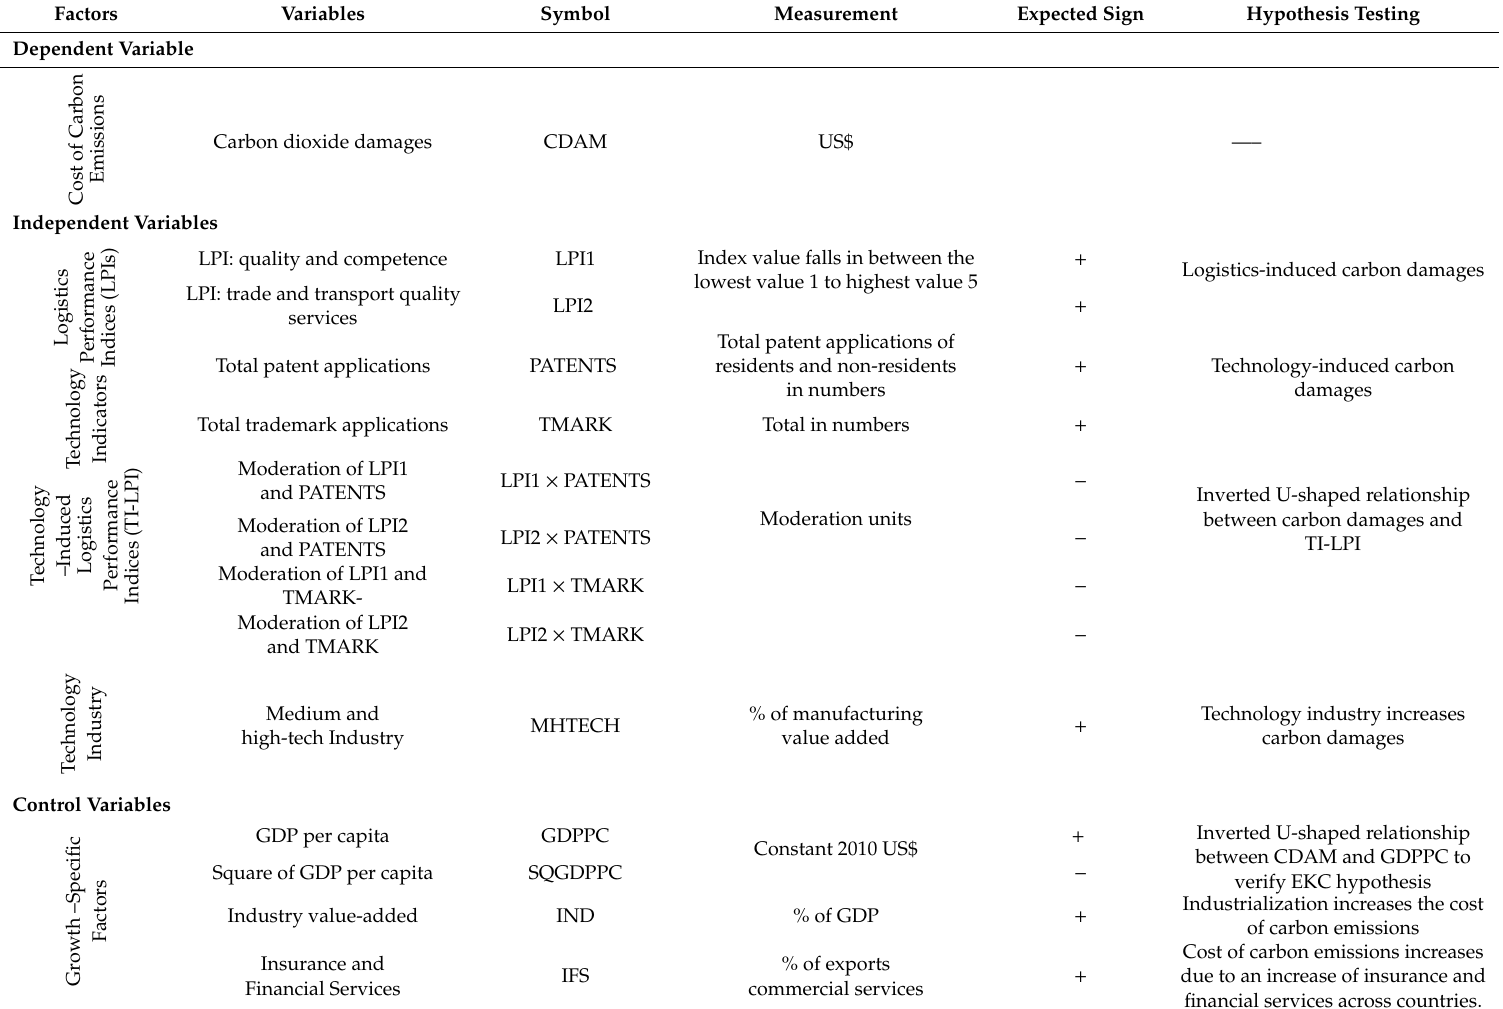
Table 2. List of Variables. Source: World Bank